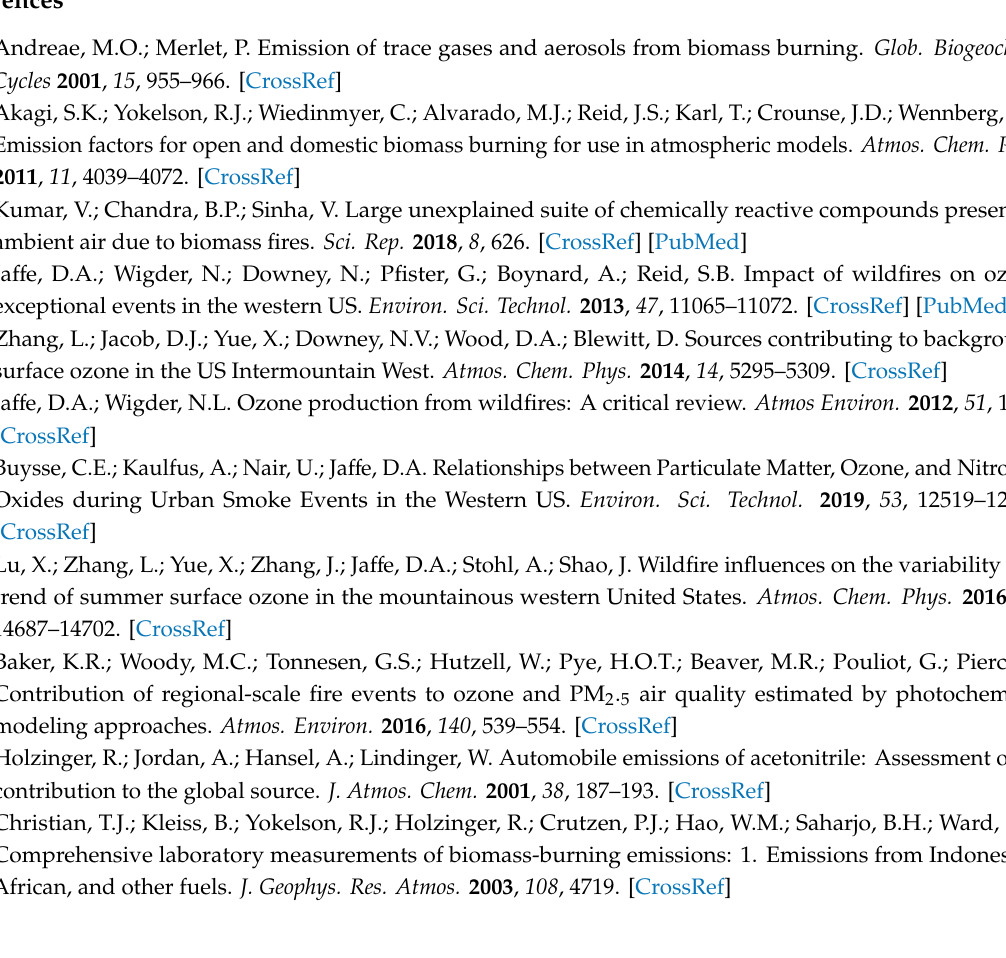
Figure S1: Linearity test for thirteen VOCs sampled using dual-bed Carboxen-Graphsphere TD tubes at di ff erent relative humidities; Figure S2: Time series of 6-hour averaged mixing ratios of VOCs measured at Spokane, Washington; Figure S3: Google Earth image (obtained on 01 / 14 / 2020 09:00 AM PST) showing the 24-hour back trajectory ensemble of air masses that arrived at 07:00 LT in Boise, Idaho (47.6670 ◦ N, 117.4014 ◦ W; 20 m a.g.l) on 06 / 08 / 2019 along with fire and smoke detected on the same day by the Hazard Mapping System